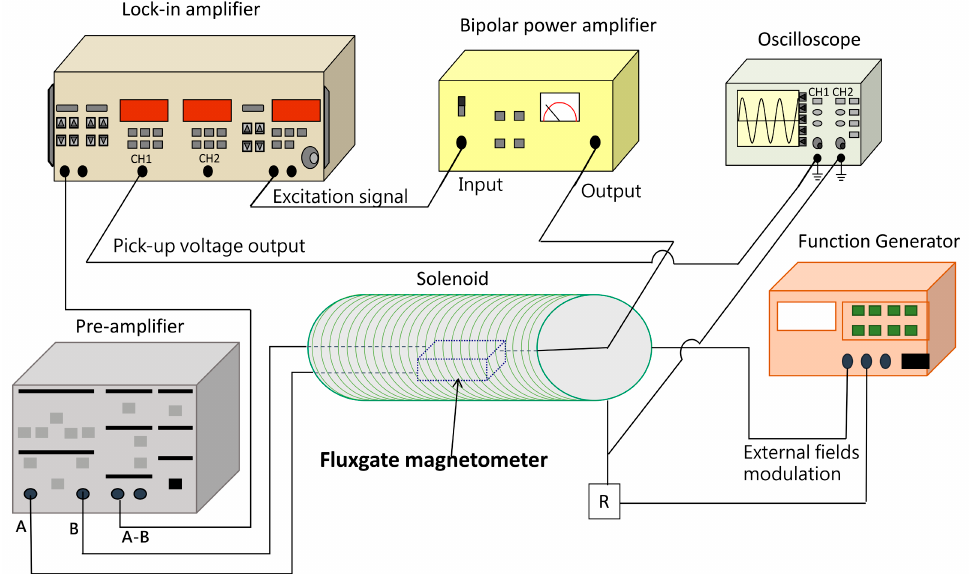
Figure 4. The systematic illustration for characteristic measurement of the fluxgate